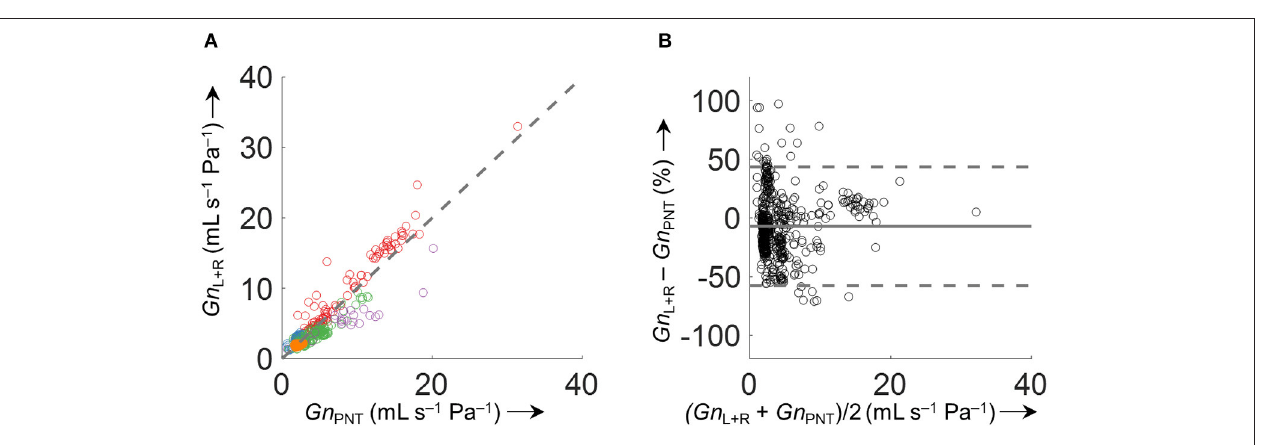
FIGURE 9 | Comparison of derived and measured conductance obtained by Fn L + R ( Gn L R ) and Gn PNT . The different colors refer to the five analyzed datasets. The dashed gray line indicates unity. (B) Bland-Altman plot. The conductance was + calculated as an average over 2min time intervals (563 data points). Conductance values of time intervals with VT Fn or VT PNT < 200 mL/s or > 800 mL/s and outliers ( Gn L R − Gn PNT > 500%) were excluded from the +